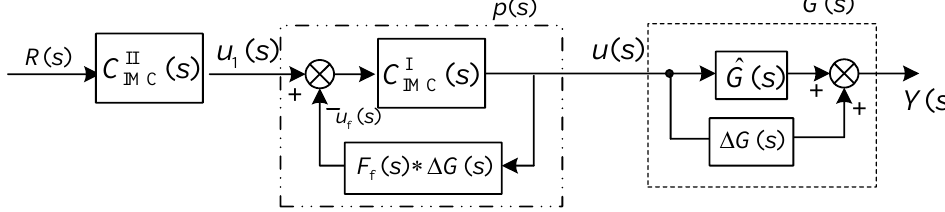
Figure 12. The equivalent open-loop block diagram of a 3-DOF-IMC.